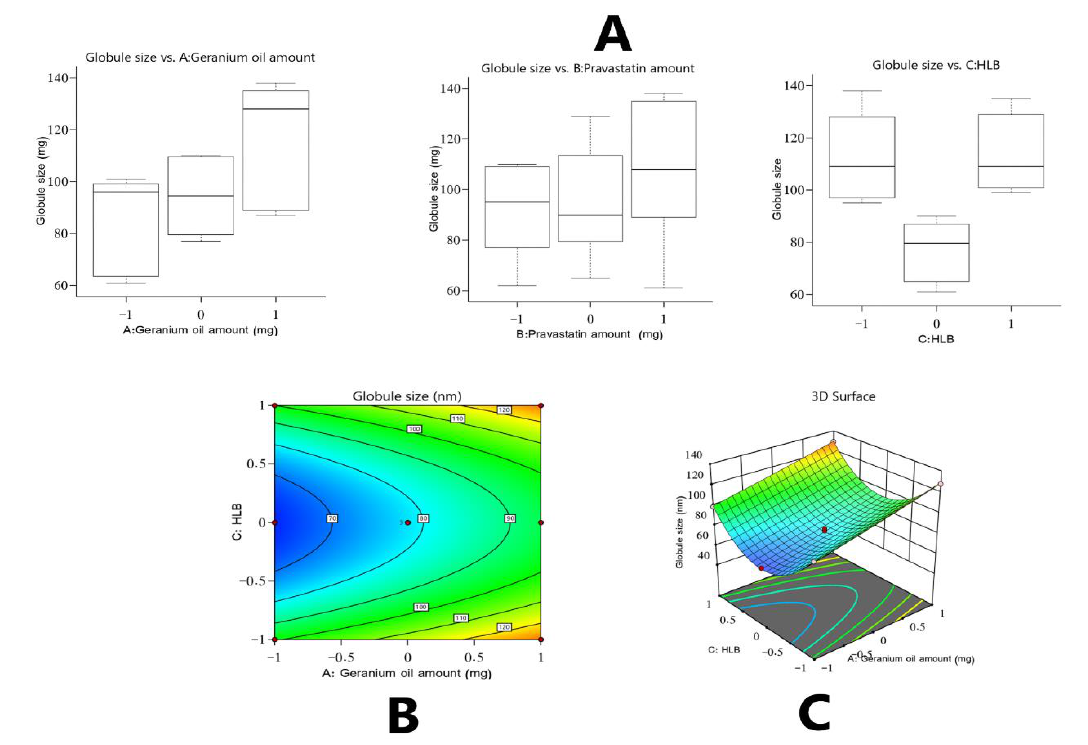
Figure 1. Main effect diagram ( A ), contour plot ( B ), and three-dimensional (3D) surface plot ( C ) showing the effects of different independent variables on the droplet size (Y 1 ) of different Gr-PV-NE formulations.